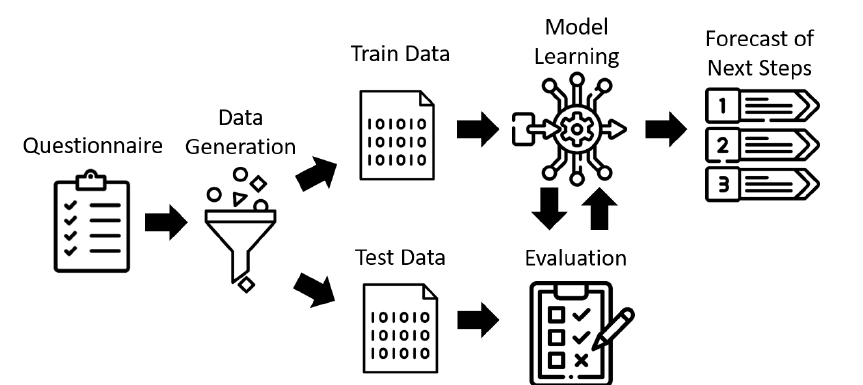
Figure 3. Concept of Machine Learning Model.